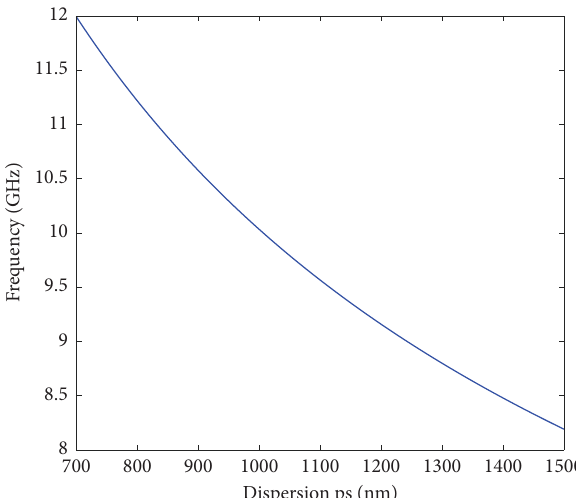
Figure 7: Curve of frequency with grating dispersion value.